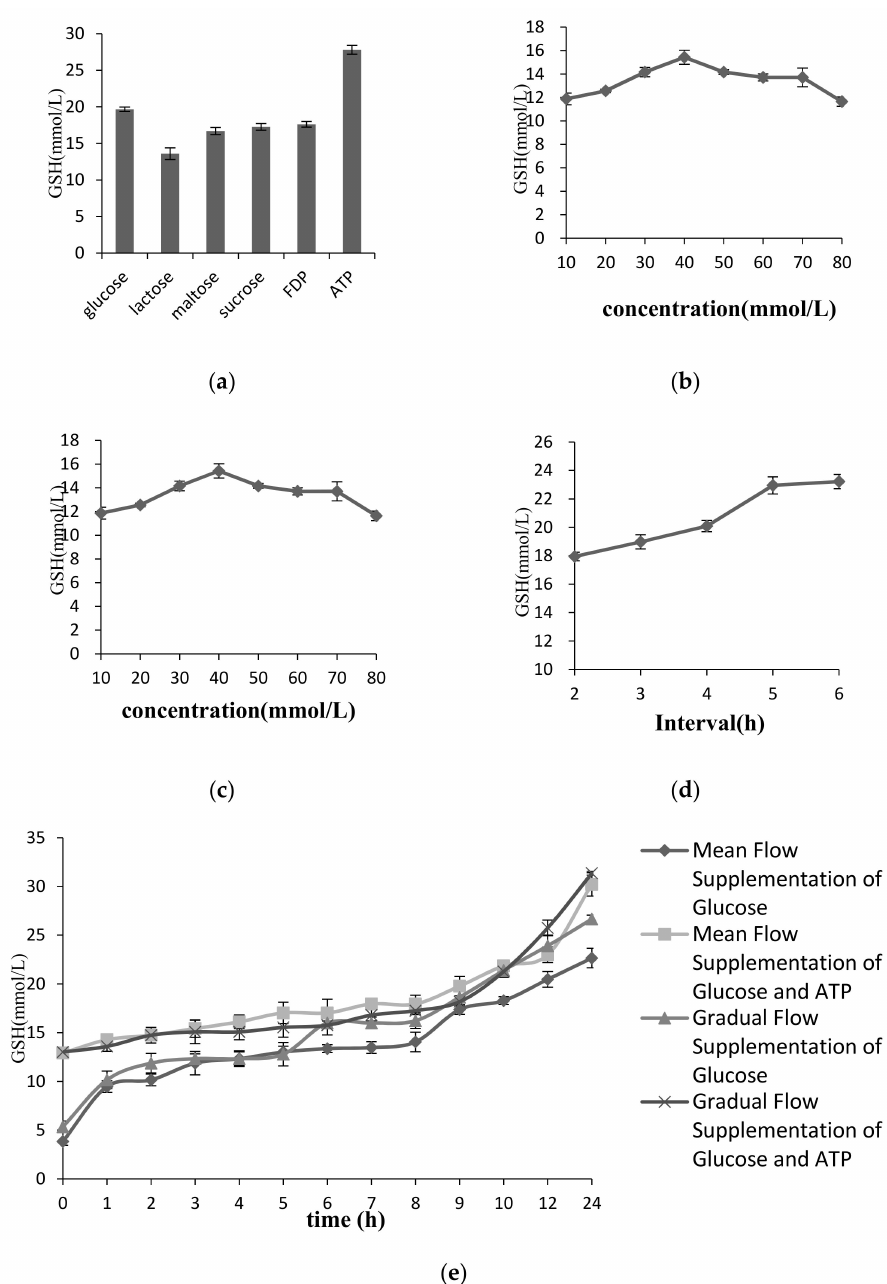
Figure 3. The e ff ect of the energy supply on the synthesis of glutathione in the reaction system with post-addition CTAB method. ( a ) the e ff ect of di ff erent carbon sources. The six carbon sources were glucose, lactose, maltose, sucrose, FDP and ATP. ( b ) the e ff ect of the initial glucose concentration, 10–80 mmol / L; ( c ) the e ff ect of the supplemental glucose concentration, 20–80 mmol / L; ( d ) the e ff ect of di ff erent supplementation times. After adding the permeabilizing agent, the interval before the supplemental glucose was added was 2 h, 3 h, 4 h, 5 h, or 6 h. ( e ) the e ff ect of di ff erent ways of replenishment. The four ways of replenishing energy were mean flow supplementation of glucose, mean flow supplementation of glucose and ATP, gradual flow supplementation of glucose, and gradual flow supplementation of glucose and